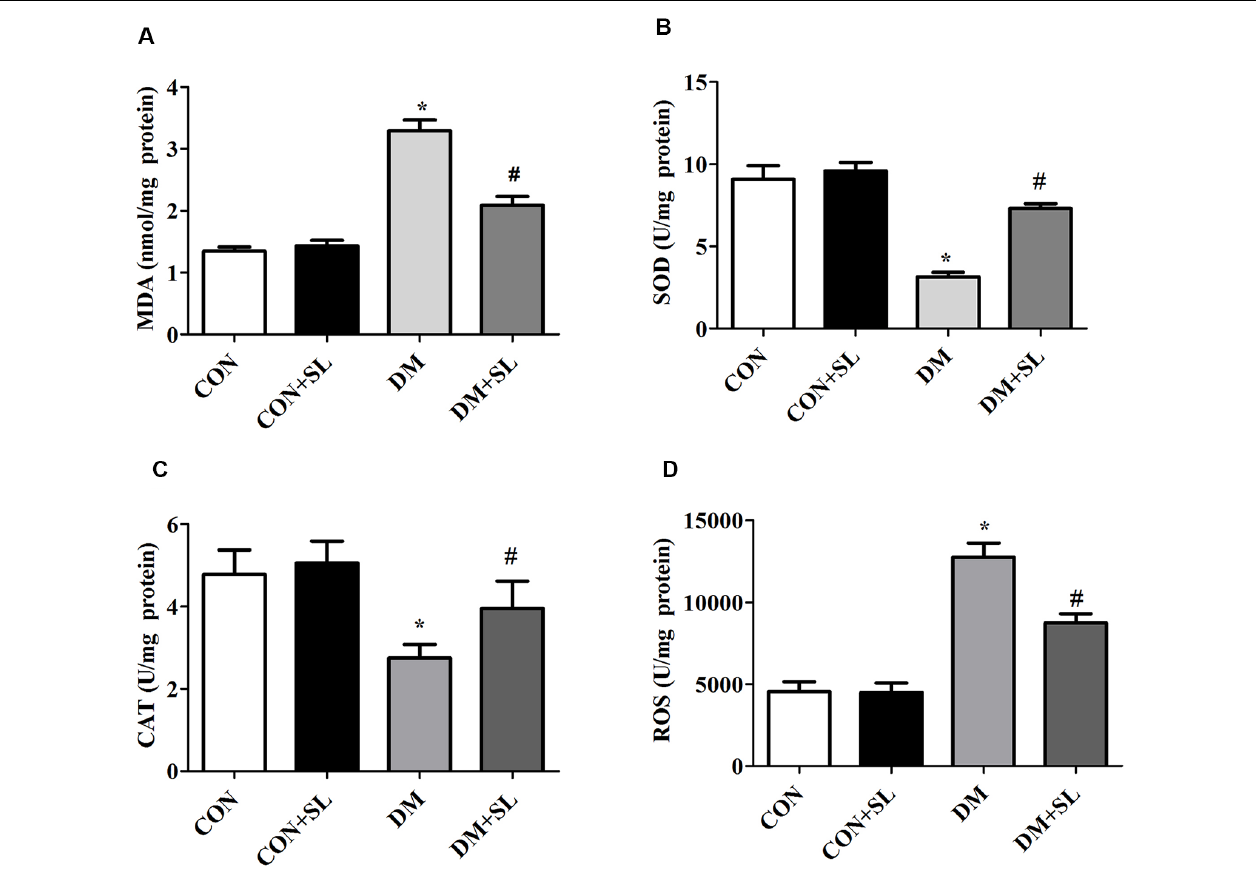
FIGURE 4 | Effect of strawberry leaf extract on oxidative stress associated factors. (A) The level of MDA; (B) The activity of superoxide dismutase (SOD); (C) The activity of CAT. (D) The level of reactive oxygen species (ROS). The data in each group are shown as the mean ± SD. * p < 0.05 vs. CON group; # p < 0.01 vs. DM group, n = 5.